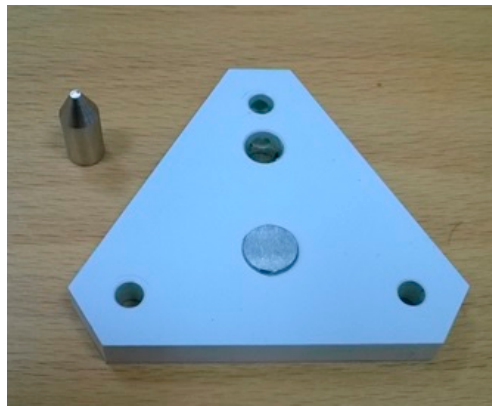
Figure 3. Sample mounted in a holder and a counter-sample used for the tests. Processes 2019 , 7 , 874